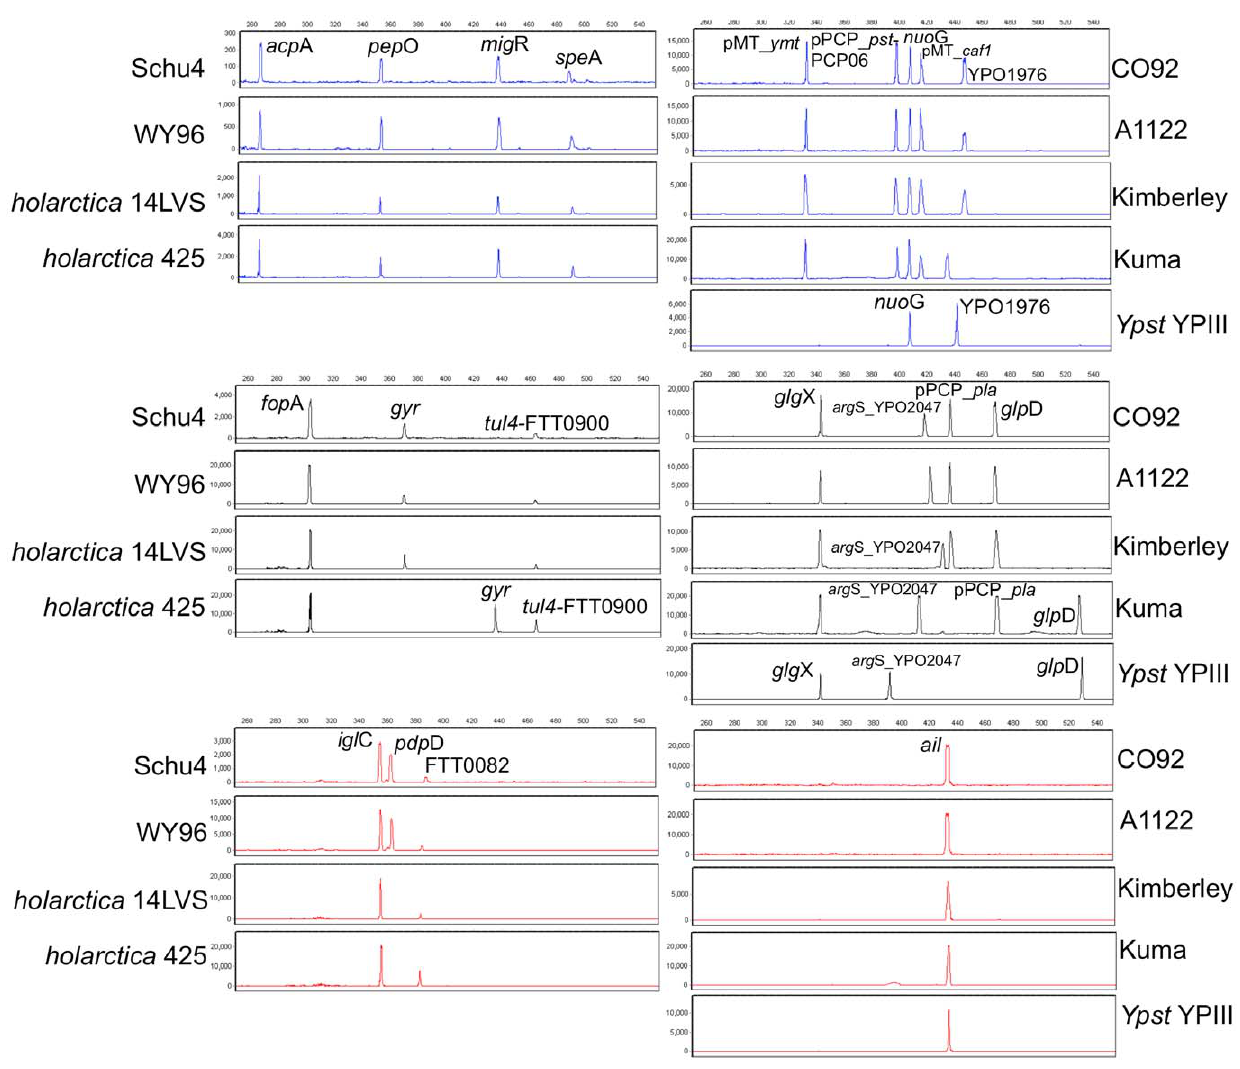
Figure 3. 10-plex PCR profiles generated from representative Ft strains (left panel) and Yp and Yp NN strains (right panel). The FAM (blue), TMR (black) and ROX (red) labeled products are aligned to emphasize the variant and non-variant fragment sizes observed across these strains. Six of ten fragments ( acp A, pep O, mig R, fop A, tul 4-FTT0900, and igl C) in the 10-plex Ft panel are invariable in length between strains subsp. tularensis SchuS4 and WY96, and subsp. holarctica 14LVS and 425. In Yp 10-plex panel, size variability is observed primarily in 4 loci ( glp D, ail, arg S-YPO2047 and YPO1976). Both Ft 10-plex and Yp 10-plex panels do not have any JOE-labeled (green) primers. For each reaction, 100 genome equivalents of each strain were used as template to